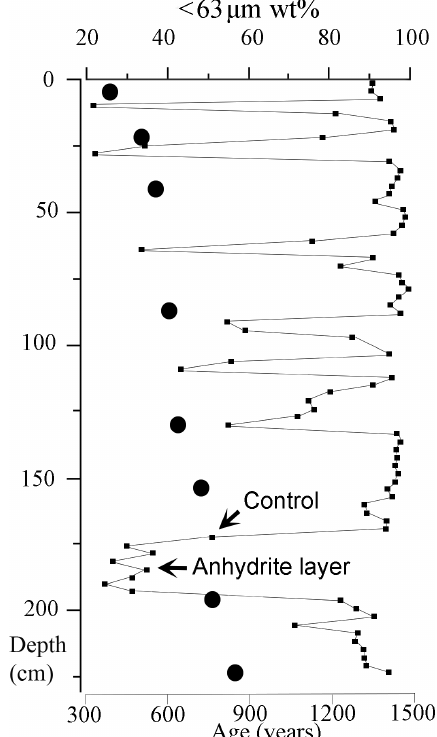
Figure 2. Grain size and age of selected layers The percentages of the small particles (<63µm) in dry weight are shown for 75 slices of the sediment core (small squares on the line). The age estimates (black circles) of the selected layers were performed using radioiso- tope 14 C of the monospecific Globigerinoides sacculifer specimens. Age errors ranged between 25 and 40 years. Anhydrite and control layers for metagenomic study were indicated by arrows.